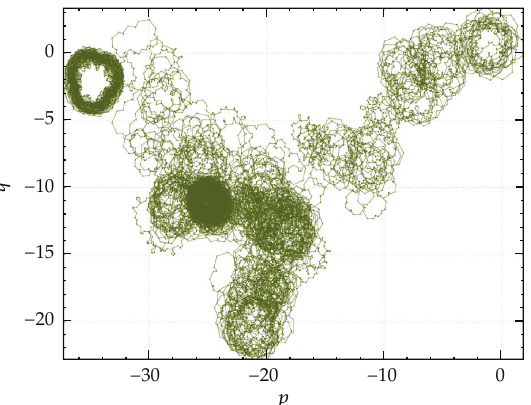
Figure 8: A regular orbit or a chaotic one? The calculation of index K verifies the chaoticity.